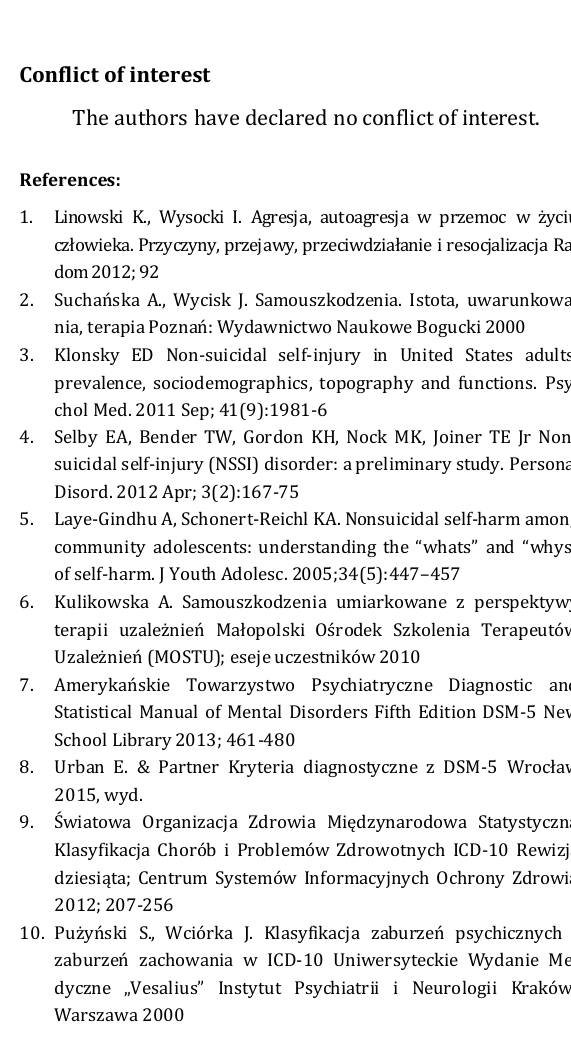
Tabela 2. Zakres definicji konstruktu w poszczególnych kwestionariuszach oraz ich cele i zastosowanie (poszerzony o skale zawarte w artykule, a nie znajdujące się w Tabeli 1 (autorstwa własnego)